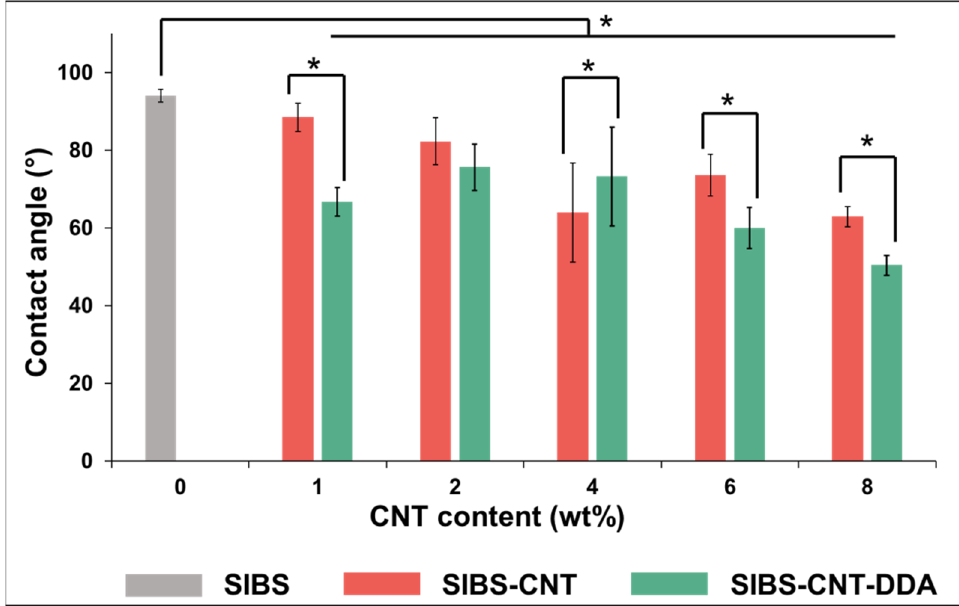
Figure 7. Water contact angles of SIBS, SIBS-CNT and SIBS-CNT-DDA films of different nanofiller concentrations. * – signifies a p -value inferior to 0.05